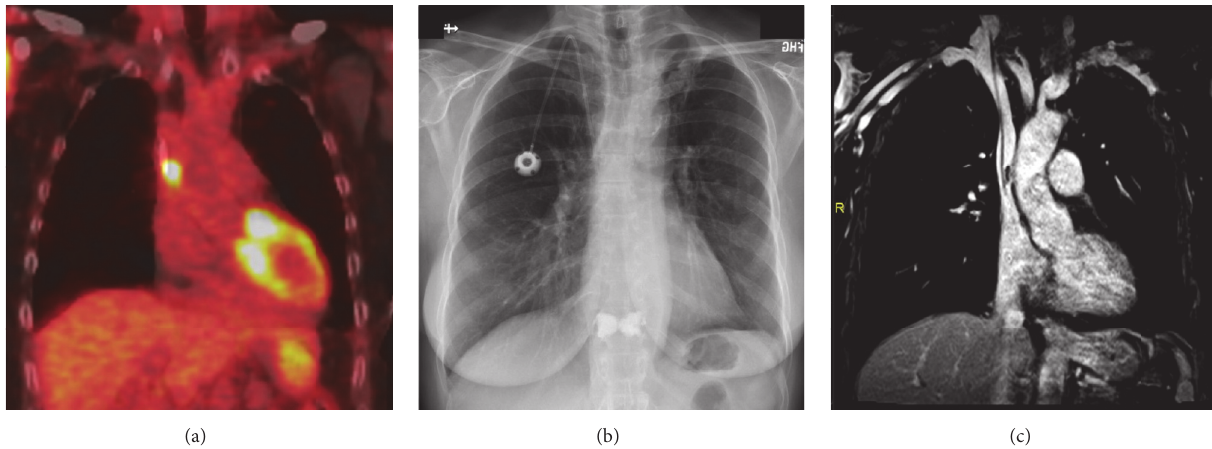
Figure 1: PET/CT, radiograph, and MR correlation. (a) Coronal reformatted PET/CT fusion image shows a moderately hypermetabolic focus at the approximate location of the catheter tip. SUV max was 8.8. (b) PA chest radiograph demonstrates a right chest wall port with its catheter tip at the cavoatrial junction. (c) Coronal T1 MR venous phase postcontrast image demonstrates a linear hypoenhancing structure along the medial lower SVC wall abutting the distal catheter. This finding was compatible with catheter related bland thrombus.